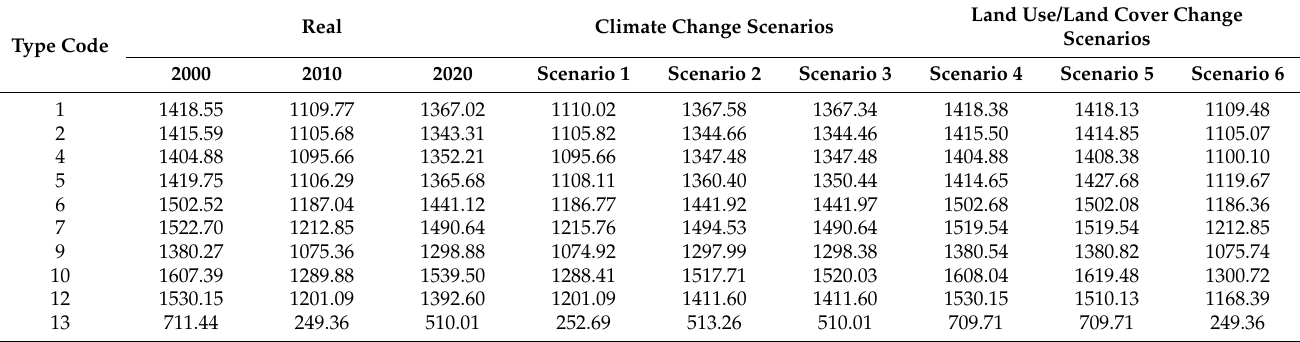
Table 4. Water yield depth of each LULC type in Dongjiang Lake Basin under different scenarios (mm).